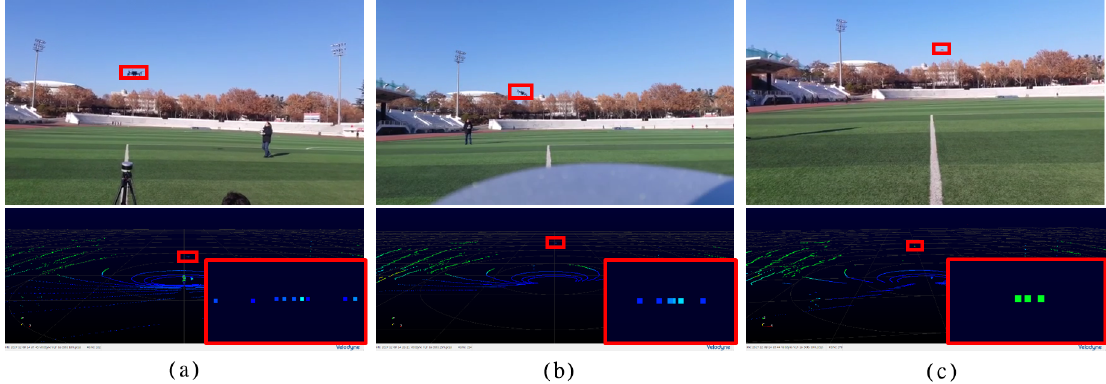
Figure 3. Limitation of target detection using 3D LiDAR sensor system. ( a ) Range = 10 m, 9 points detection, ( b ) Range = 25 m, 6 points detection, ( c ) Range = 50 m, 3 points detection.